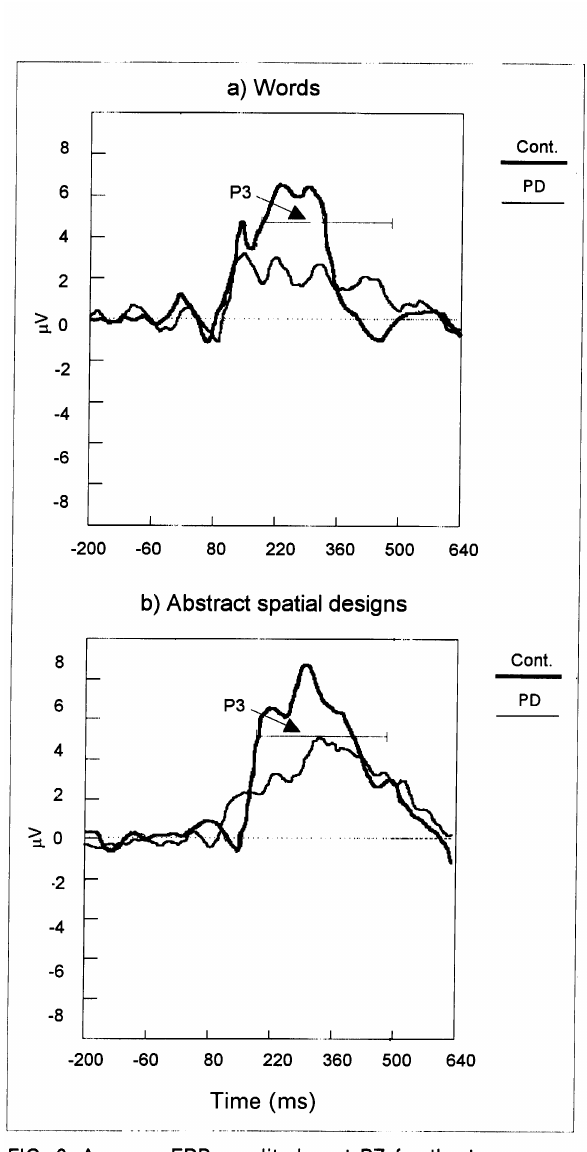
FIG. 6. Average ERP amplitudes at PZ for the two groups under the two conditions recorded after presentation of the memory set items